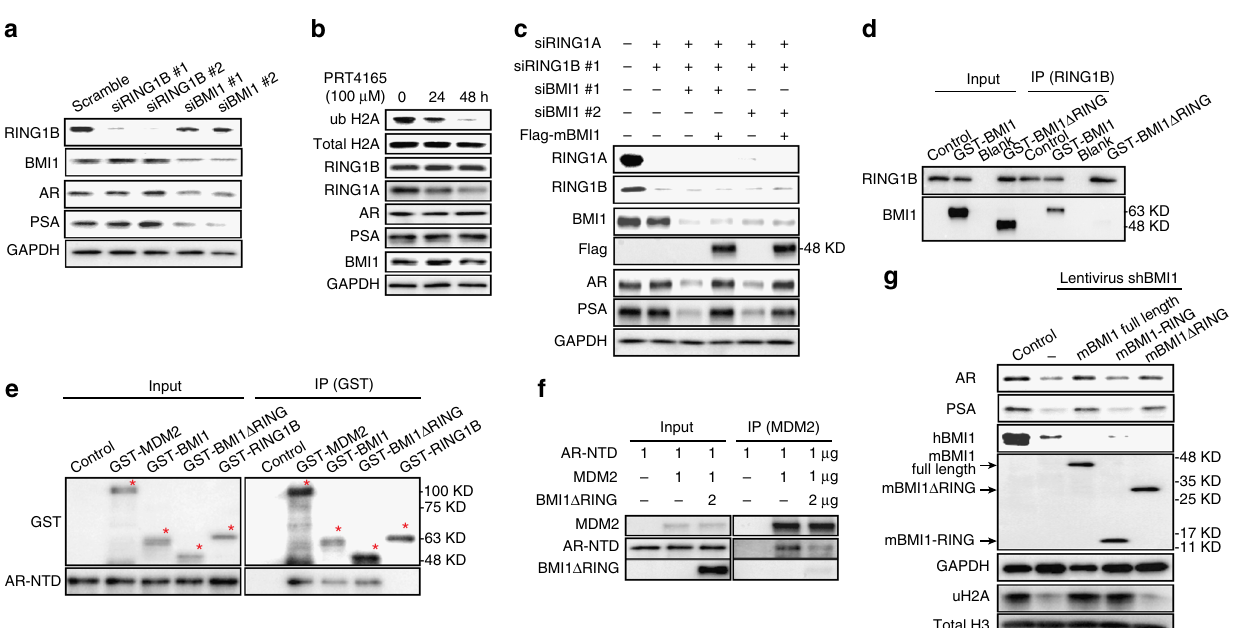
Fig. 3 BMI1 regulates AR signaling independently of PRC1. a RING1B or BMI1 was depleted by siRNA in C4-2 cells. After 48 h, cells were lysed and blotted for BMI1, RING1B, AR, PSA, and GAPDH. b C4-2 cells were treated with PRT4165 (100 μ M) for 24 or 48 h. ubH2A, RING1B, RING1A, AR, PSA, and BMI1 were tested by western blot. Total H2A and GAPDH were used as loading controls. c C4-2 cells were transfected with siRNA duplexes as indicated. At 24 h post transfection, cells were infected by mouse fl ag-BMI1 lentivirus or vector lentivirus and incubated for an additional 48 h. Cells were then lysed and immunoblot analysis was performed with indicated antibodies. This anti-BMI1 antibody only recognizes human BMI1, but not mouse BMI1. GAPDH was used as a loading control. d GST-BMI1 or GST-BMI1 Δ RING was incubated with RING1B for 12 h followed by IPs with an anti-RING1B antibody. e His-AR- NTD was incubated at 4 °C with GST-MDM2, GST-BMI1, GST-BMI1 Δ RING, or GST-RING1B for 12 h, followed by GST pull-down and immunoblot analysis with anti-GST and anti-AR antibodies. f Puri fi ed AR-NTD and MDM2 proteins were incubated with puri fi ed BMI1 Δ RING protein at indicated